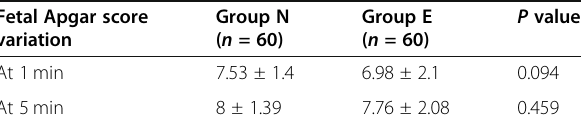
Table 3 Apgar score variation Fetal Apgar score variation